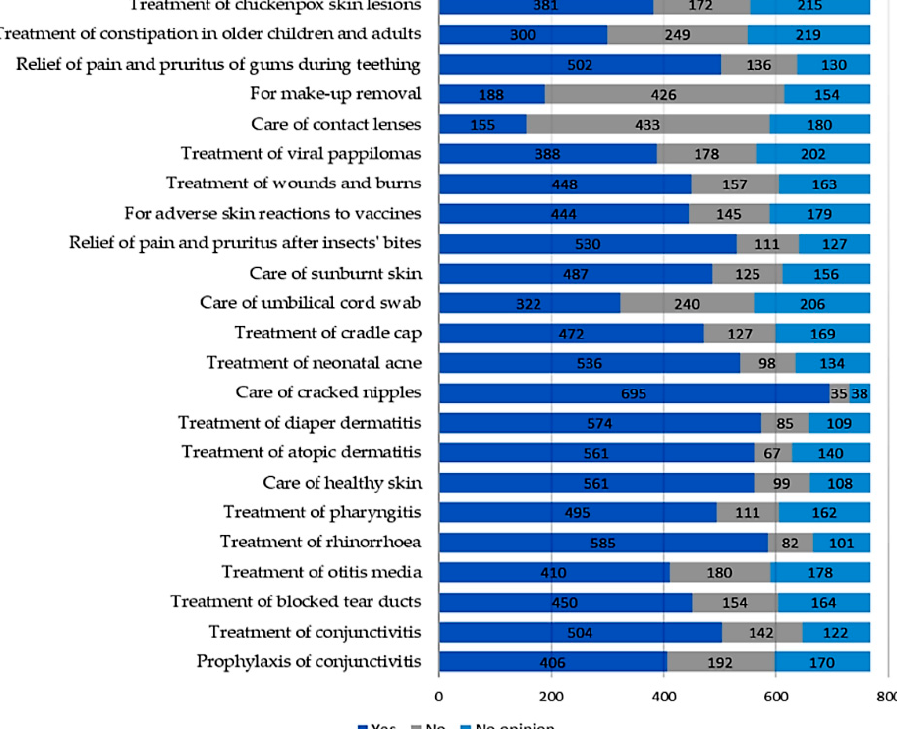
Figure 5. Declared willingness to use selected non-nutritional uses of breast milk in the future. The list